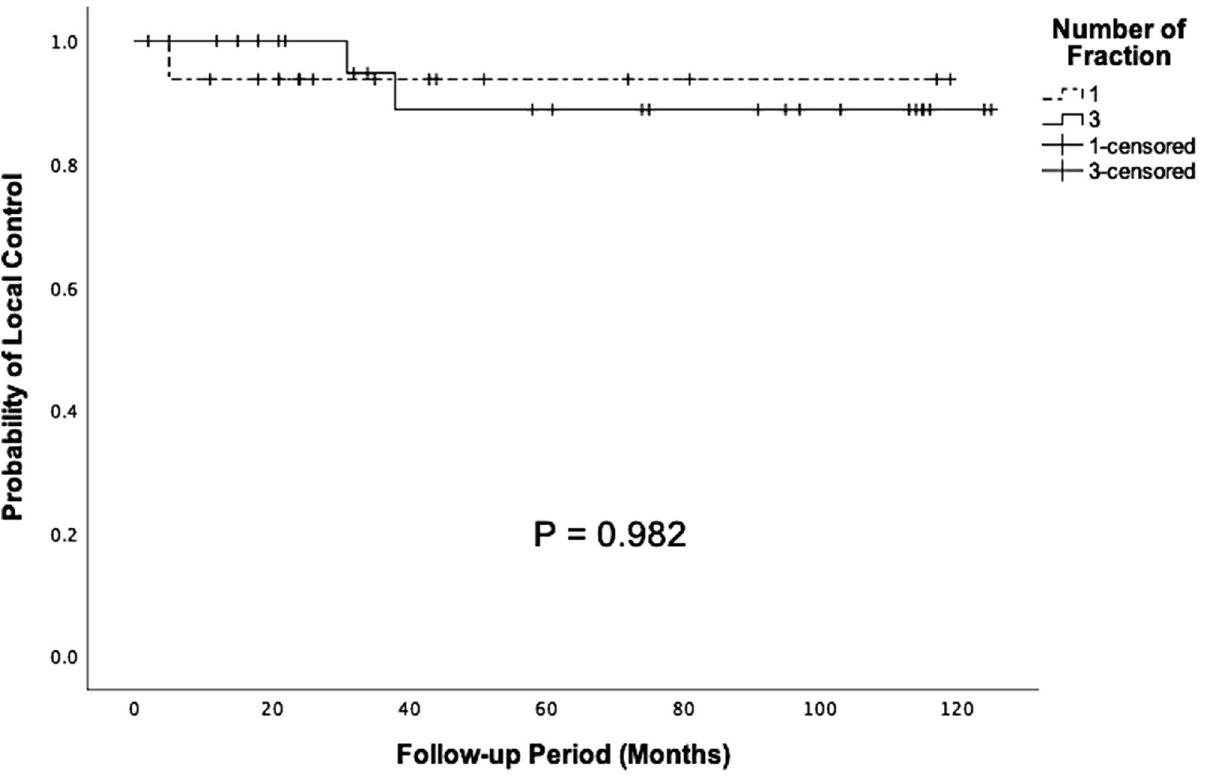
Figure 5. Kaplan–Meier analysis of clinical outcome in patients with large meningioma (tumor volume > 10 cm 3 ) after SSRS and FSRT (p =